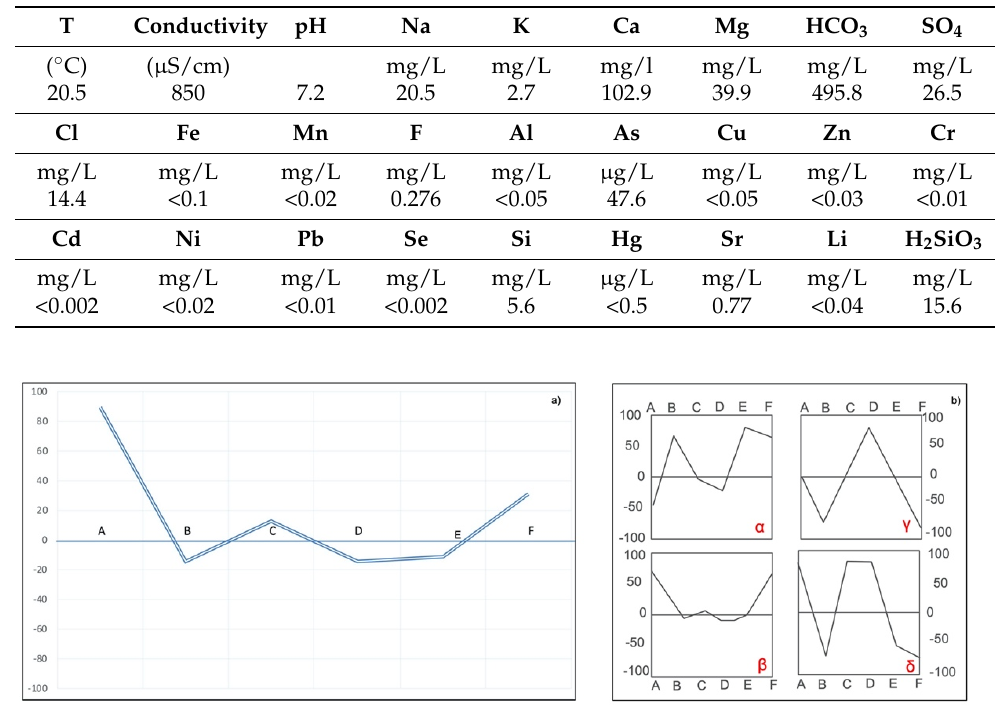
Table 5. Physical-chemical features of geothermal waters on the site of Ljuba.